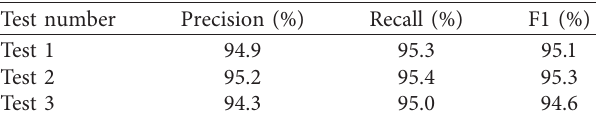
Table 4: Accuracy indicators of classification model.